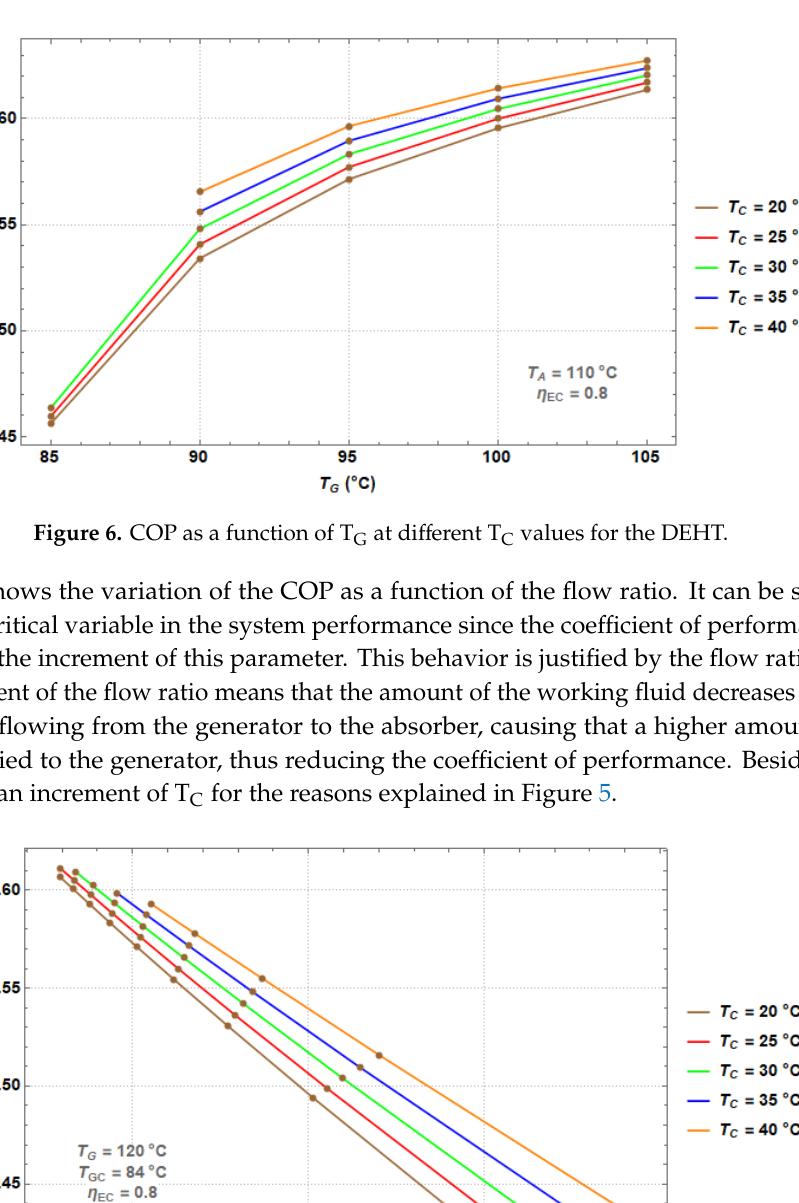
Figure 5. COP as a function of GTL at different T C values for the DEHT.